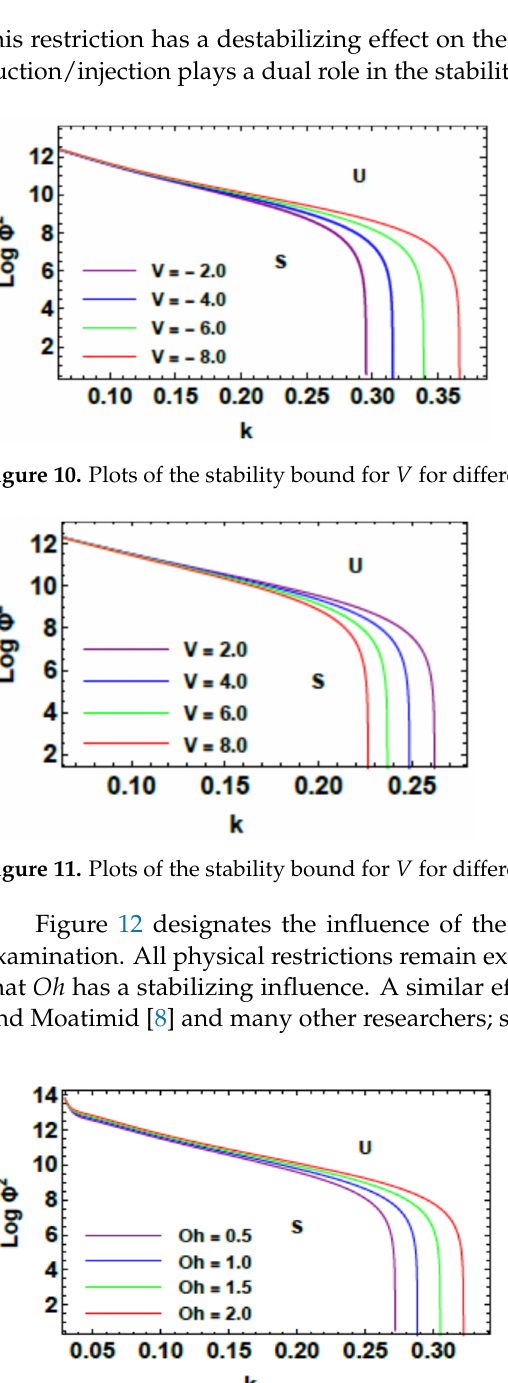
Figure 12. Plots of the stability bound for 2 Φ Log versus k for different values the parameter Oh . Figure 13 designates the influence of the elasticity quantity El on the stability